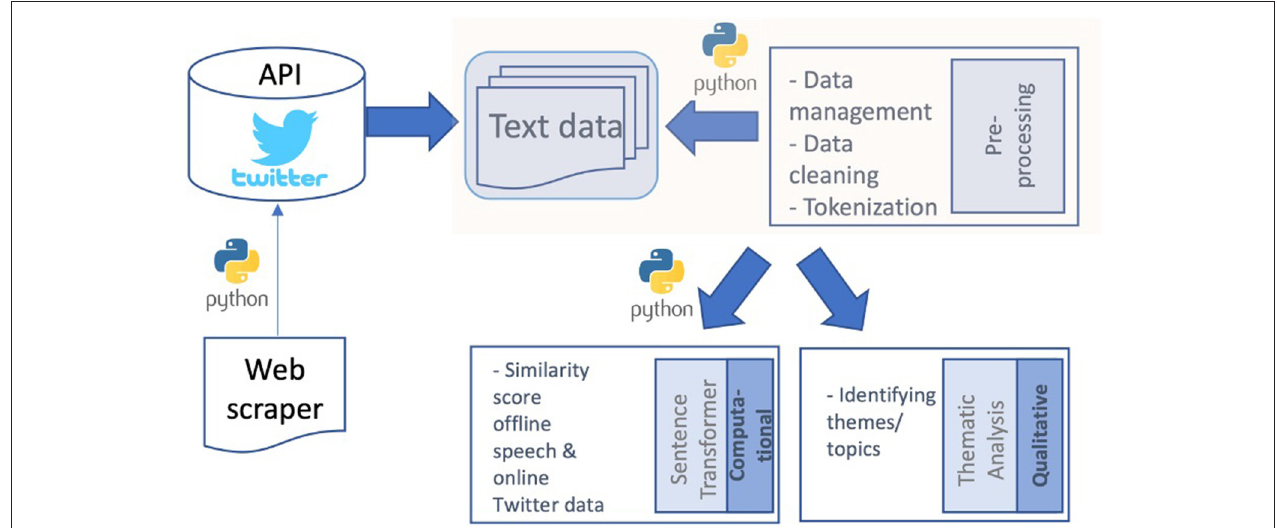
FIGURE 1 | Research